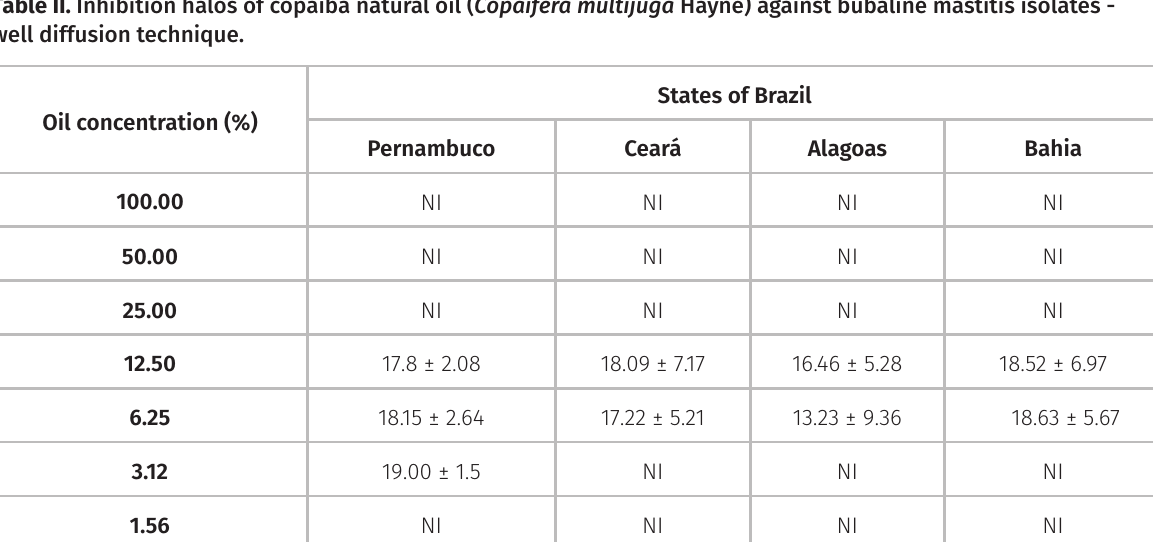
Halos determined in mm. NI = No inhibition halo formation. Value represents the mean and standard deviation of the inhibition zone in